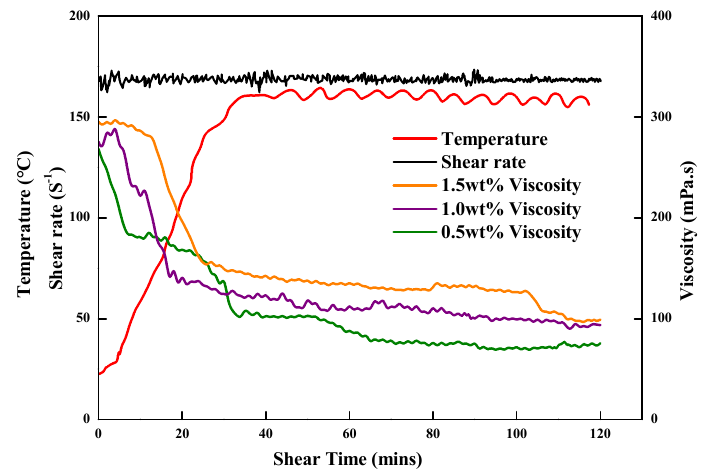
Figure 10. Shear resistance tests of the ZJL-1 fracturing fluid.